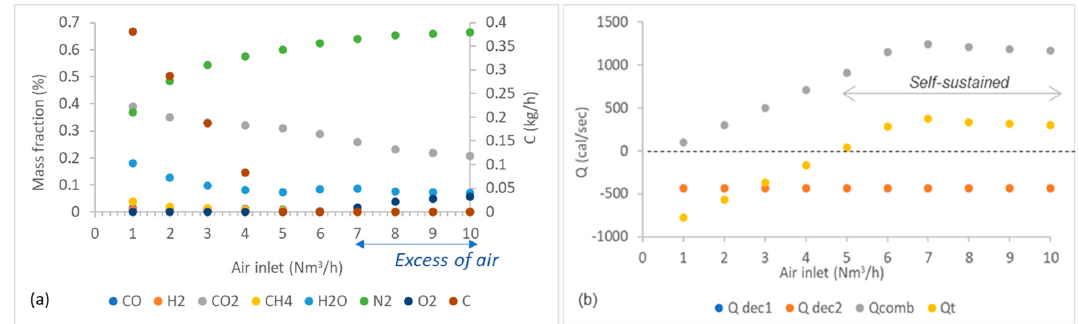
Figure 10. Mass ( a ) and energy ( b ) balances for the co-incineration of 30 g mixture/min. Simulation #3: 20 g mixture/min: 10 g wood/min + 10 g rice straw/min